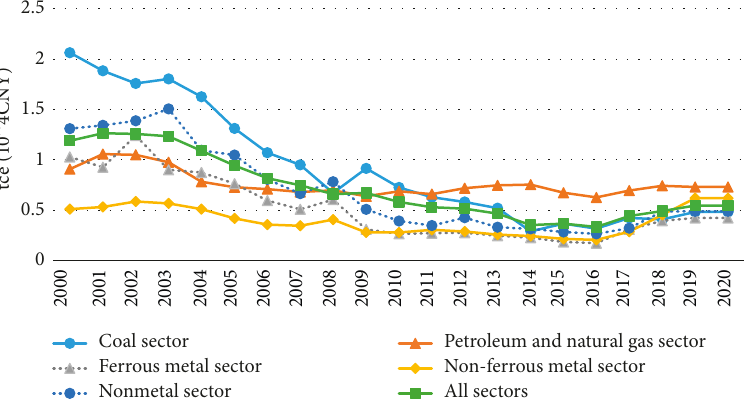
Figure 5: Comparative analysis of energy intensity of mining industry and its subsectors from 2000 to 2020. Table 7: Carbon emissions of mining industry and its subsectors from 2000 to 2020.